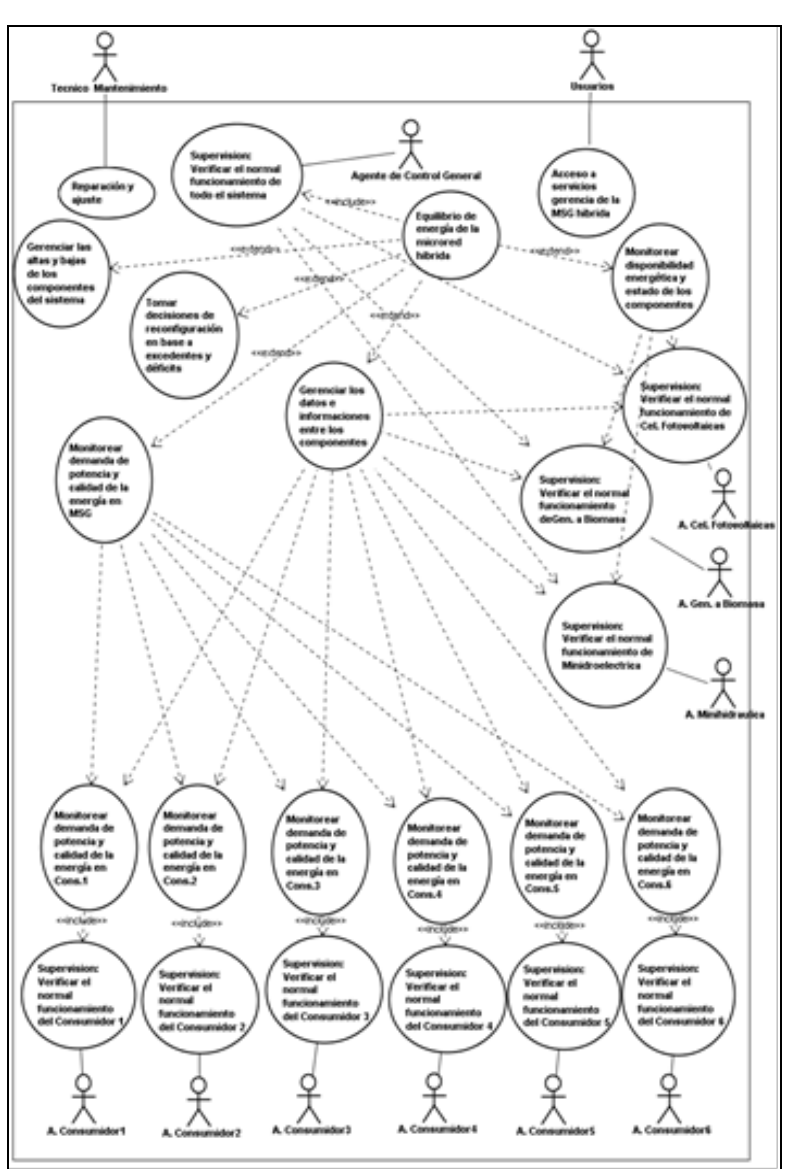
Figura 5: Diseño UML de los casos de uso del MAS para MSG hibrida. Fuente: Los autores,